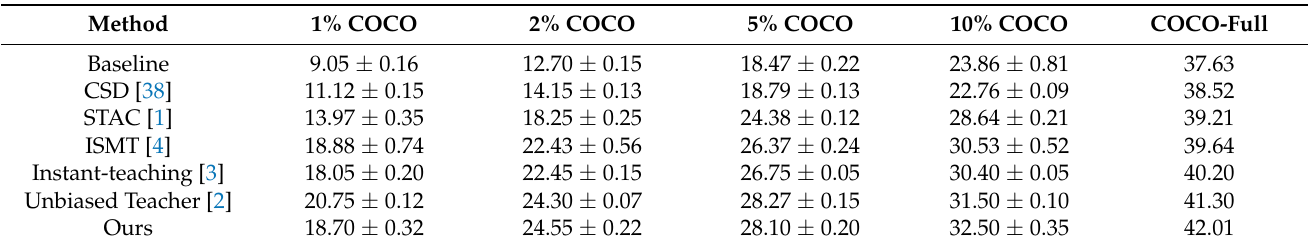
Table 1. Experimental results on the COCO dataset.